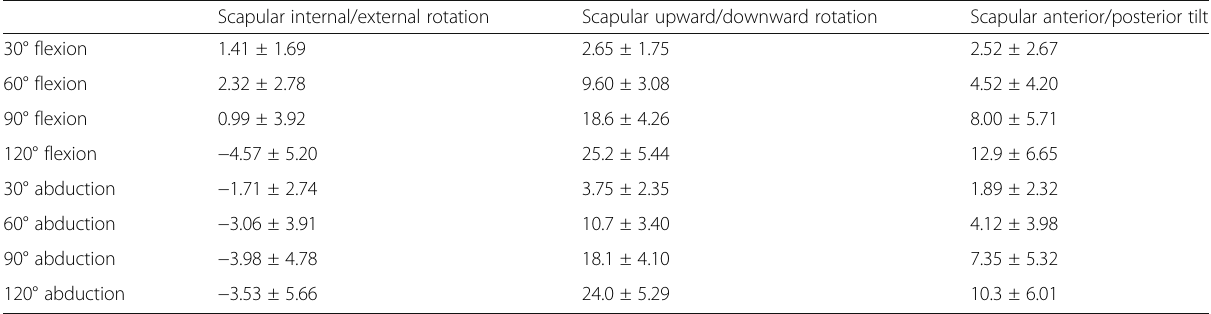
Table 1 Representative values of the three scapular angles during flexion and abduction at 4 specific angulations (30°-60°-90° and 120°). The data is presented as mean ± standard deviation of the 200 measurements made